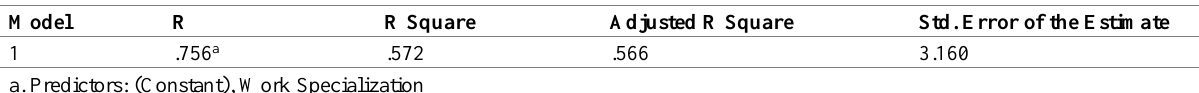
Table 6: Model Summary